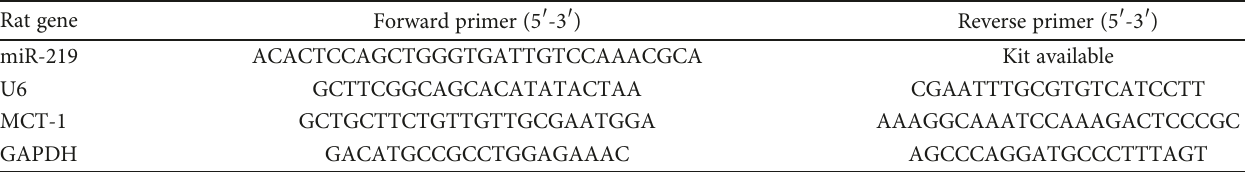
Table 2: Forward and reverse primer sequences for